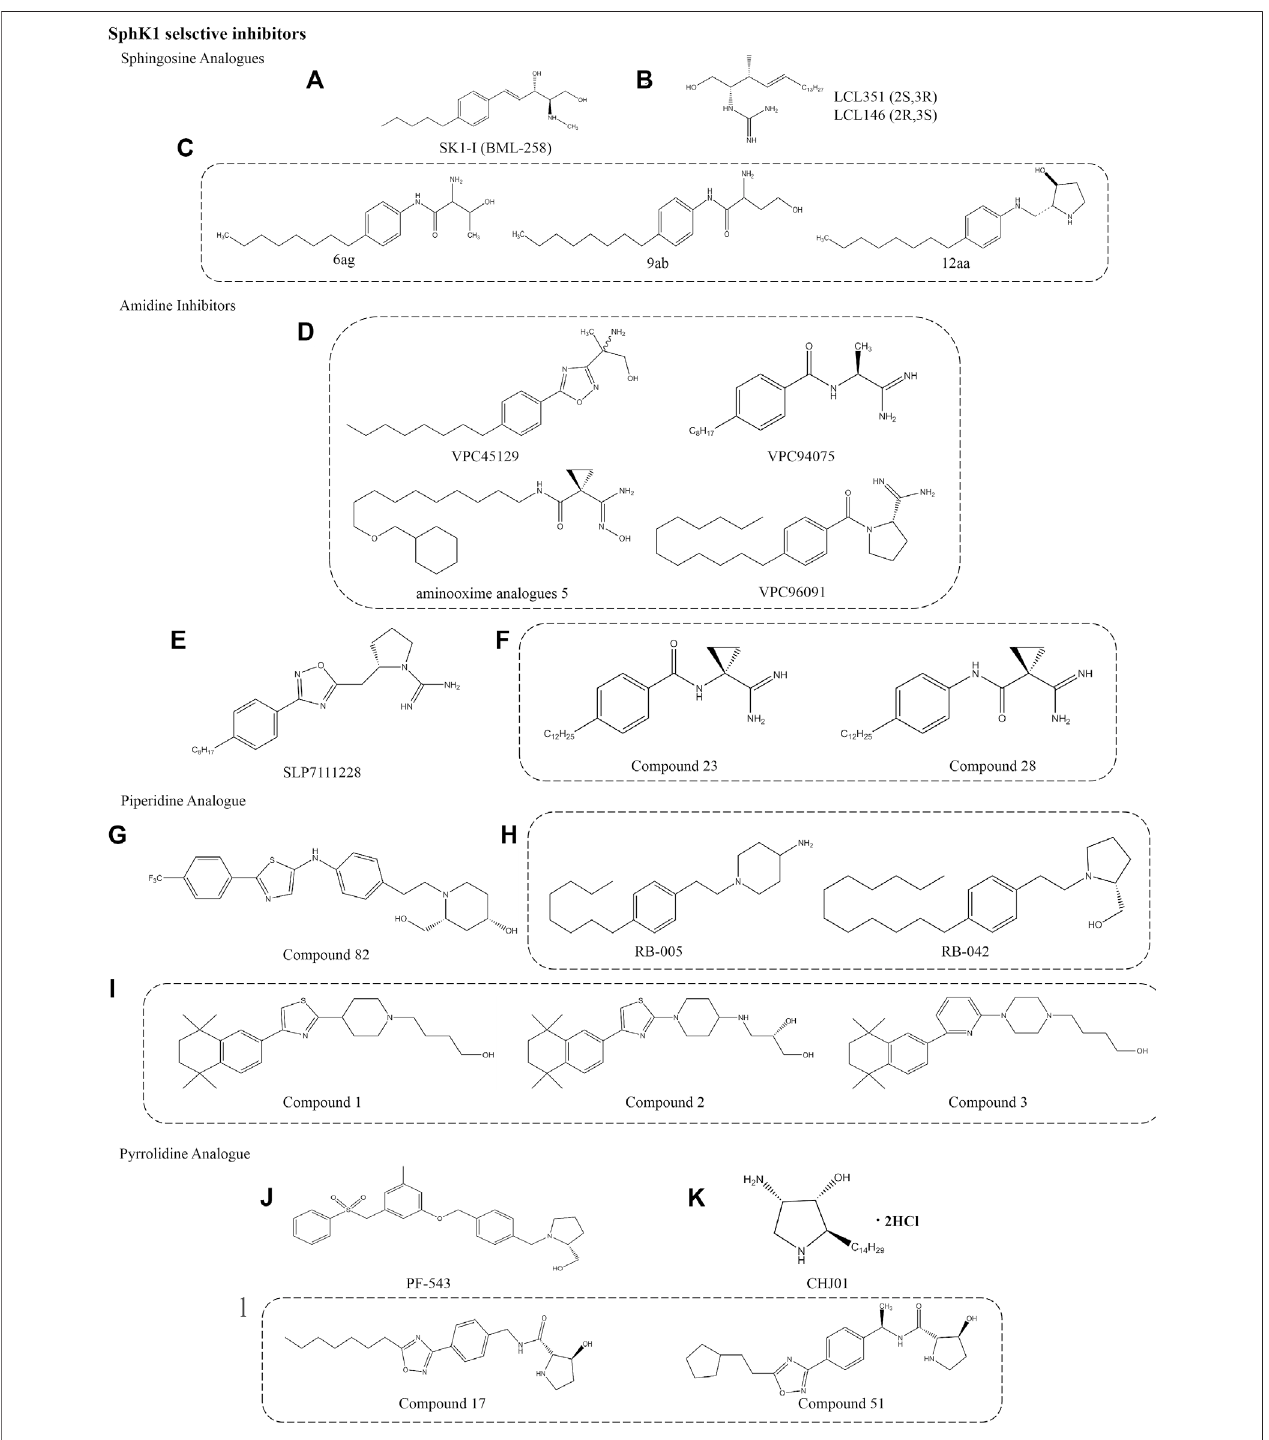
FIGURE 3 | Structures of selective SphK1